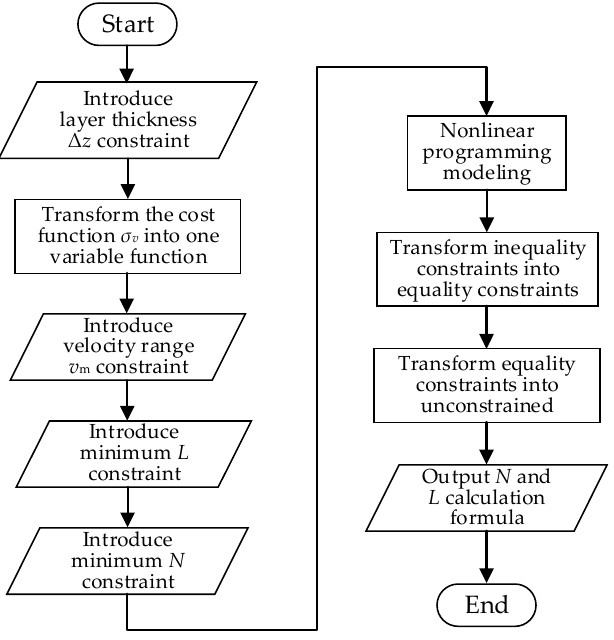
Figure 3. Flow chart of the VEAP method.